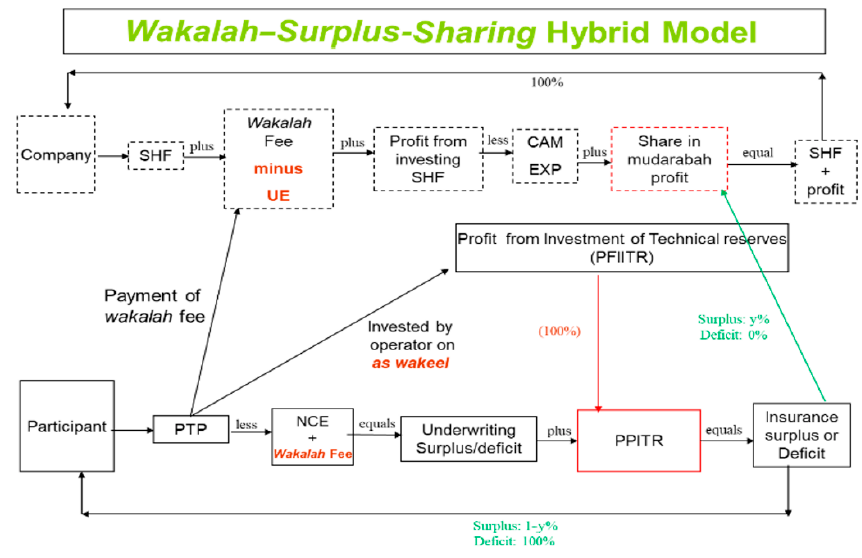
Figure 5. Wakalah – Surplus-Sharing hybrid operational model of takaful.